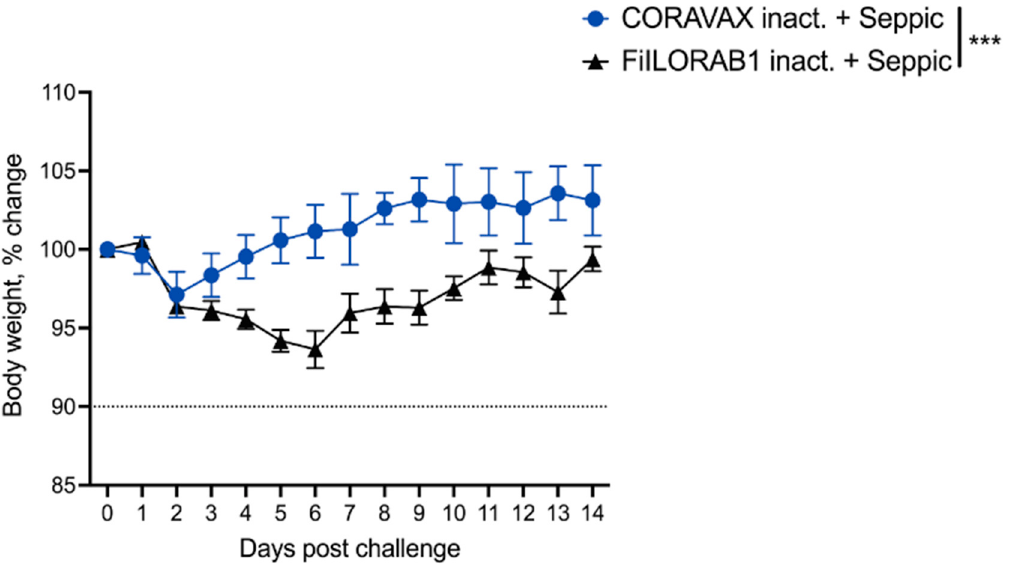
Figure 4. Hamster body weight after SARS-CoV-2 infection . Hamsters were vaccinated on day 0 and challenged intranasally with 10 4 PFU SARS-CoV-2 on day 39. Percent change in body weight. CORAVAX vaccine group is shown in blue, and FILORAB1 group is in black. n = 15 for FILORAB1 group (5 hamsters each euthanized on days 3, 7, and 14 p.c.) and n = 15 for CORAVAX group (5 hamsters each euthanized on days 3, 7, and 14 p.c.). Body weight p value determined by Wilcoxon test; p > 0.123 (ns), p < 0.033 (*), p < 0.002 (**), p < 0.001 (***).